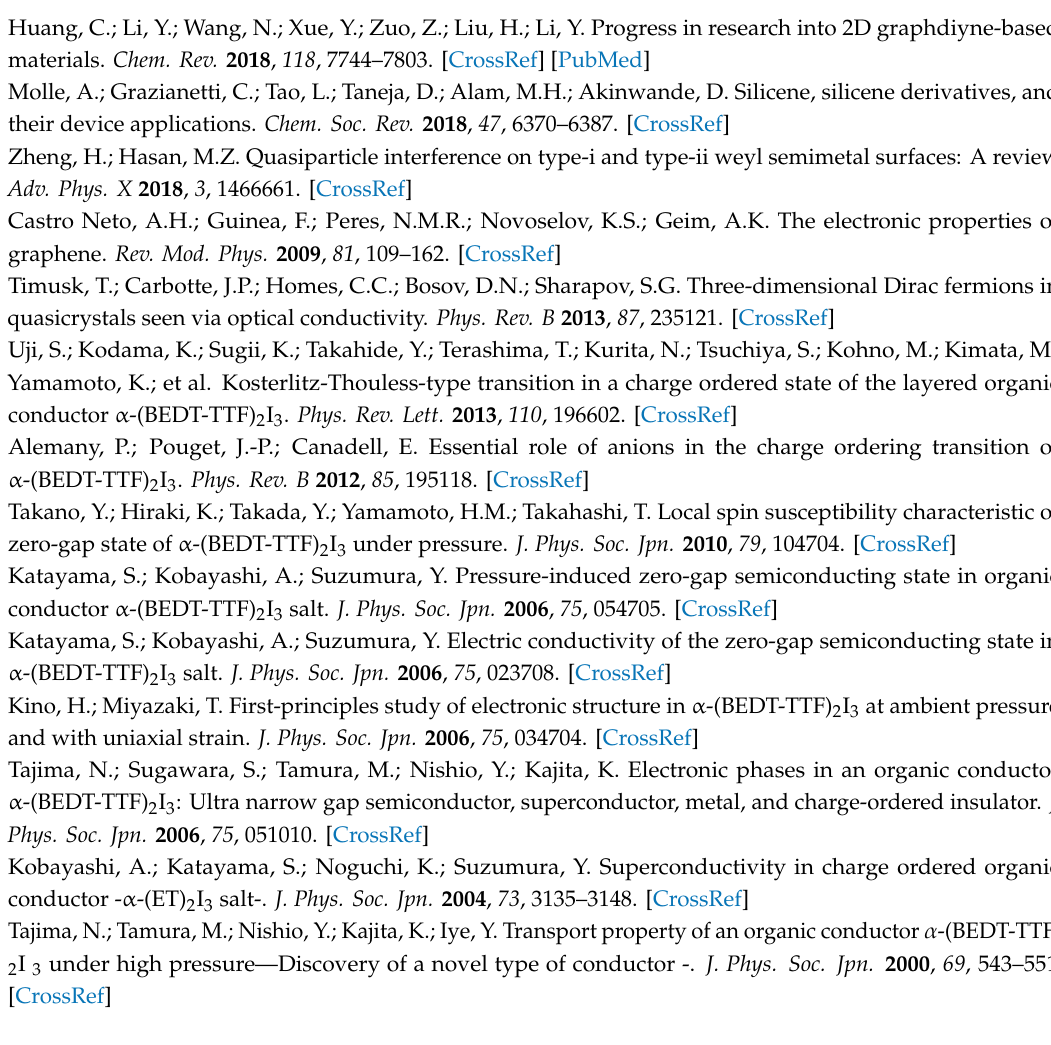
Figure A2. Reproducibility, sample- and / or measurement-dependences of temperature-dependent molar magnetic susceptibility of α -STF 2 I 3 . ZFC1 / FC1 and ZFC2 / FC2 denote independent sets of obtained results using the polycrystalline α -STF 2 I 3 of di ff erent batches containing independently synthesized neutral STF and (n-C 4 H 9 ) 4 NI 3 (ZFC = Zero-field cooling process, FC = Field cooling process). The χ T curve in Figure A2 is based on ZFC2 / FC2 data, while that in Figure 5 is based on ZFC1/FC1 data.